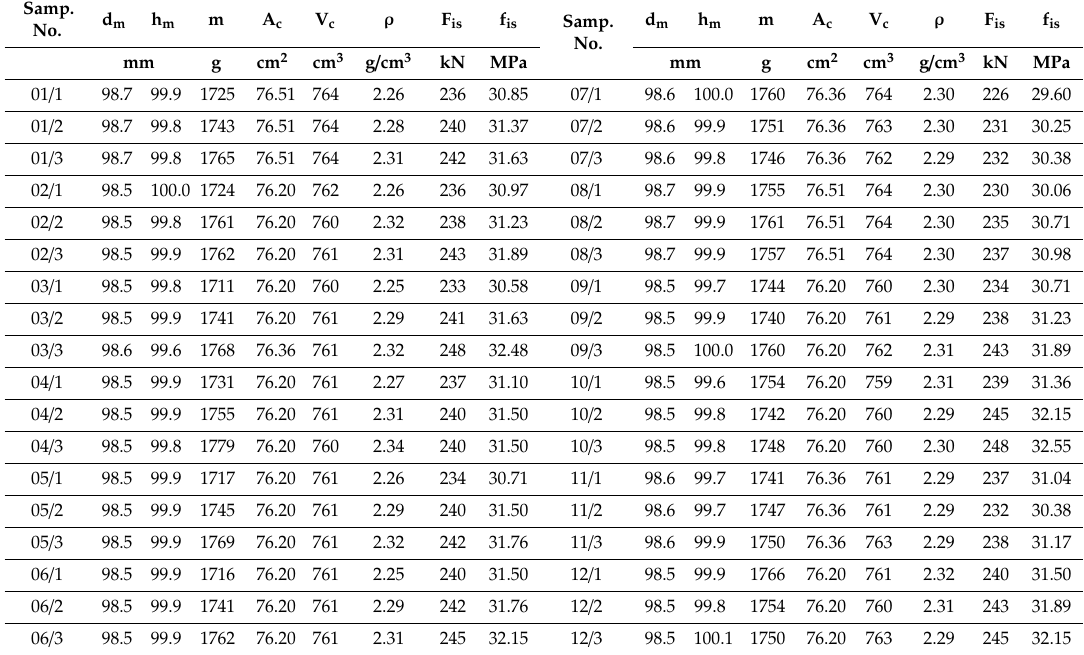
Table 4. The results of concrete compressive strength